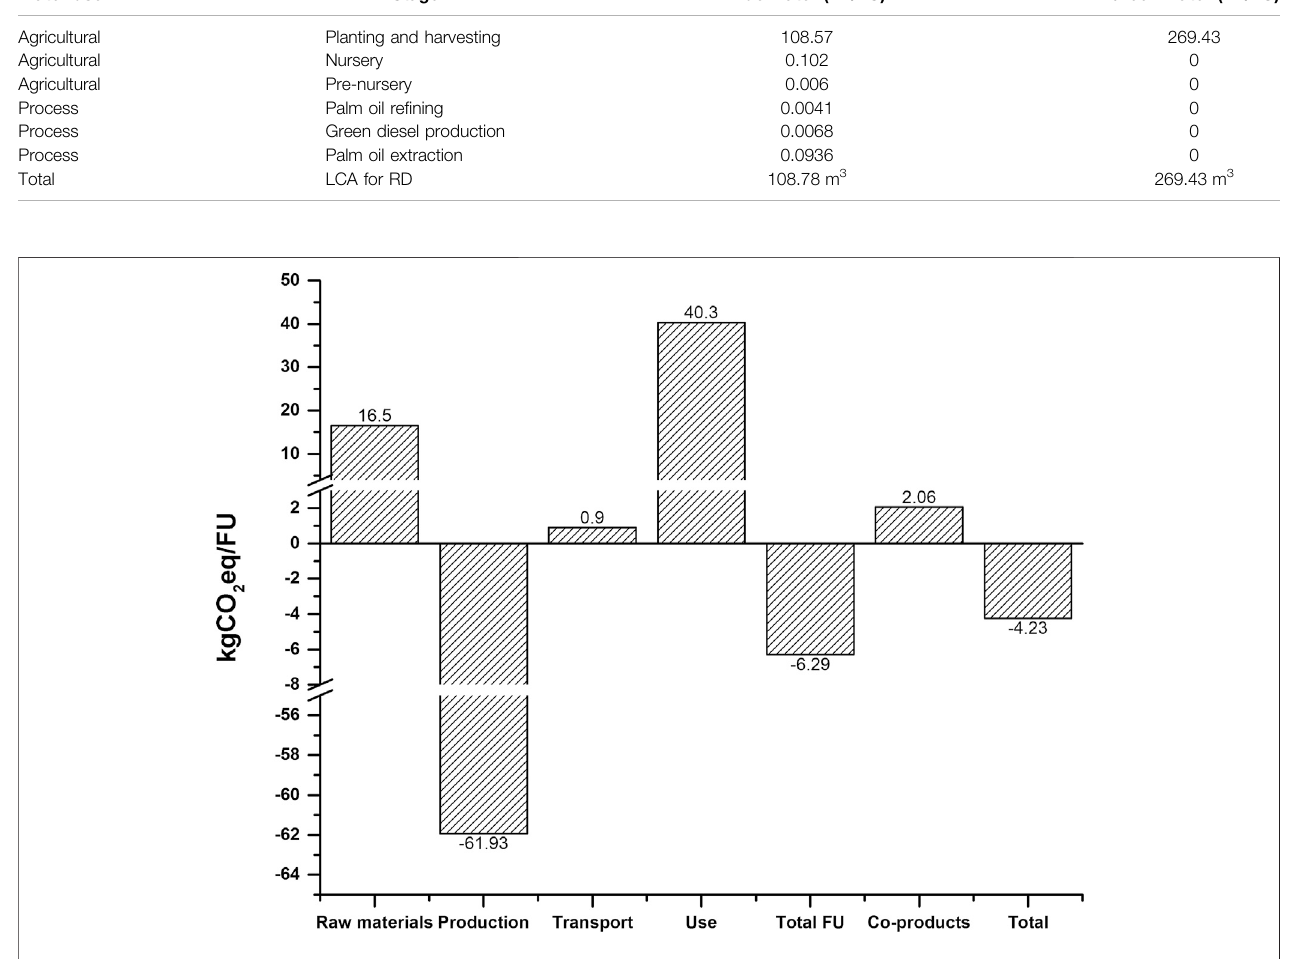
FIGURE 2 | Carbon